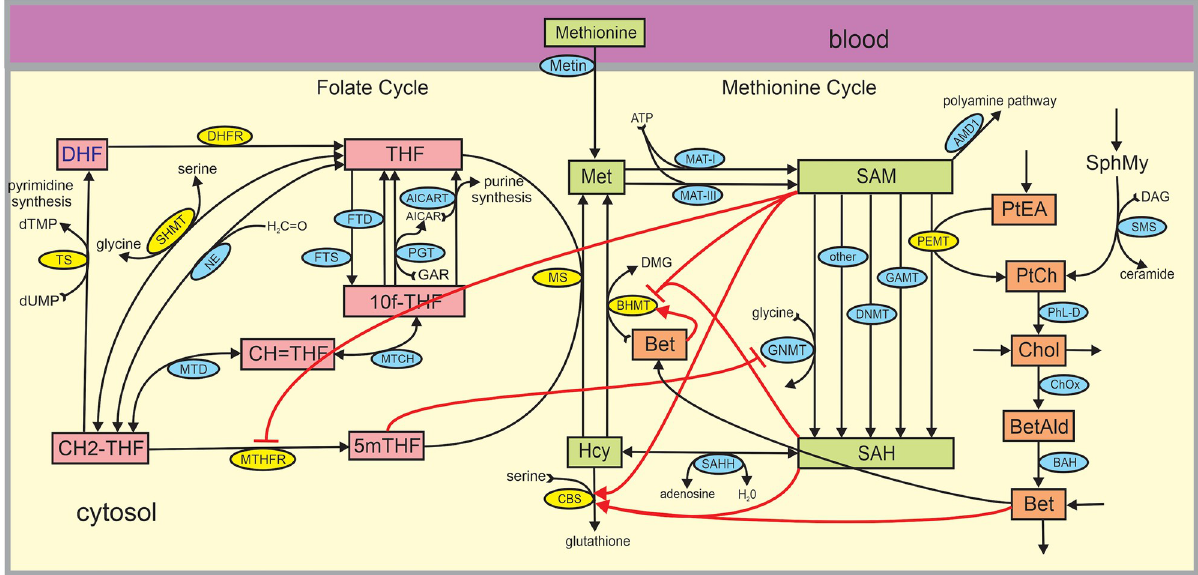
Fig 1. One-carbon metabolism. Substrates are indicated by rectangular boxes, green in the methionine cycle and red in the folate cycle. Each black arrow represents a biochemical reaction and the blue and yellow ellipses on the arrows contain the acronyms of the enzymes that catalyze the reactions. The yellow ellipses indicate the enzymes that are up- or down-regulated in females (see Table 1). Each red arrow is a long-range allosteric influence, either activation (arrow) or inhibition (bar). Substrate abbreviations: Met, methionine; SAM, S-adenosylmethionine; SAH, S-adenosylhomocysteine; Hcy, homocysteine; 5mTHF, 5-methyltetrahydrofolate; THF, tetrahydrofolate; 10fTHF, 10-formyltetrahydrofolate; DHF, dihydrofolate; CH2-THF, 5,10-methylenetrahydrofolate; CH = THF, 5,10-methenyltetrahydrofolate; SphMY, sphingomyelin; PtEA, phosphotidylethanolamine; Cho, choline; Bet-Ald, betaine aldehyde; Bet, betaine. Enzyme abbreviations: AICAR(T), aminoimidazolecarboxamide ribonucleotide (transferase); FTD, 10-formyltetrahydrofolate dehydrogenase; FTS, 10-formyltetrahydrofolate synthase; MTCH, 5,10-methylenetetrahydrofolate cyclohydrolase; MTD, 5,10-methylenetetrahydrofolate dehydrogenase; MTHFR, 5,10-methylenetetrahydrofolate reductase; TS, thymidylate synthase; SHMT, serine hydroxymethyltransferase; PGT, phosphoribosyl glycinamidetransformalase; DHFR, dihydrofolate reductase; NE, nonenzymatic interconversion of THF and 5,10-CH2-THF; MAT-I,methionine adenosyl transferase I; MAT-III, methionine adenosyl transferase III; AMD1, adenosylmethionine decarboxylase; GNMT, glycine N-methyltransferase; AS3MT, arsenic methyltransferase; PEMT, phosphotidylethanolamine methyltransferase; GAMT, gunadino-acetate methyltransferase; DNMT, DNA-methyltransferase; SAHH, S-adenosylhomocysteine hydrolase; CBS, cystathionine β -synthase; MS, methionine synthase; SMS, sphingomyelin synthase; PhL-D, phospholipade D; ChOx, choline oxidase; BAH, betaine aldehyde dehydrogenase; BHMT, betaine-homocysteine